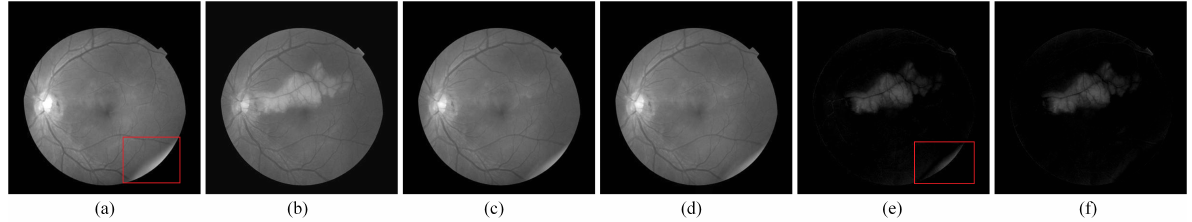
Figure 6. The result of the image with large lesions by RPCA method. ( a ) Normalized reference image; ( b ) normalized current image; ( c ) reconstructed low-rank background by RPCA; ( d ) reconstructed low-rank background by P-RPCA; ( e ) sparse change region by RPCA; and ( f ) sparse change region by P-RPCA. The red circle marks the distraction of the light spot in the reference image for the RPCA method.